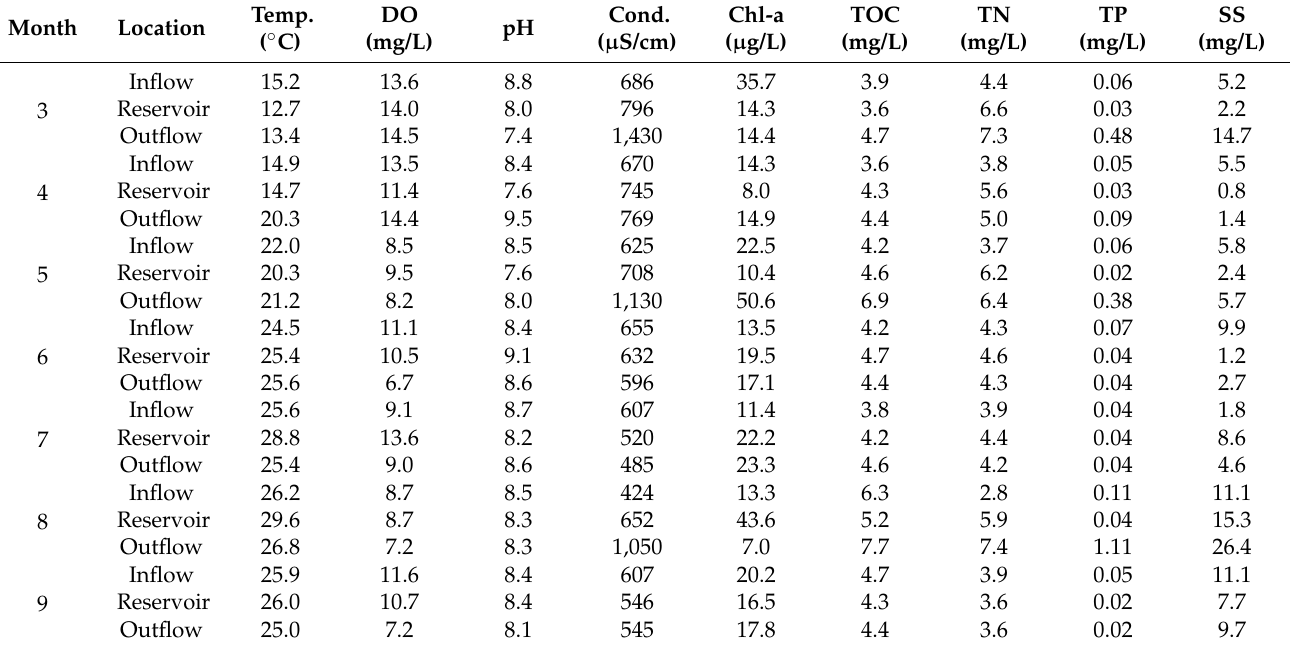
Table 1. Environment variables at each sampling sites in Singal